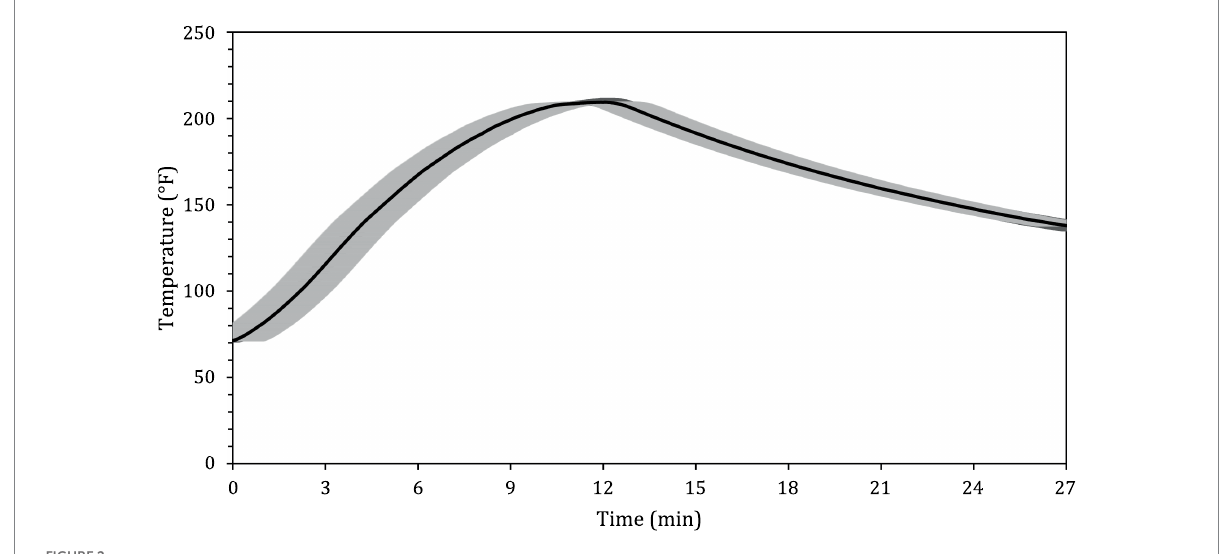
FIGURE 2 Mean (± SE; n = 5) internal temperature profile of pizza during baking at 500 ° F for 12 min followed by 15 min of ambient air